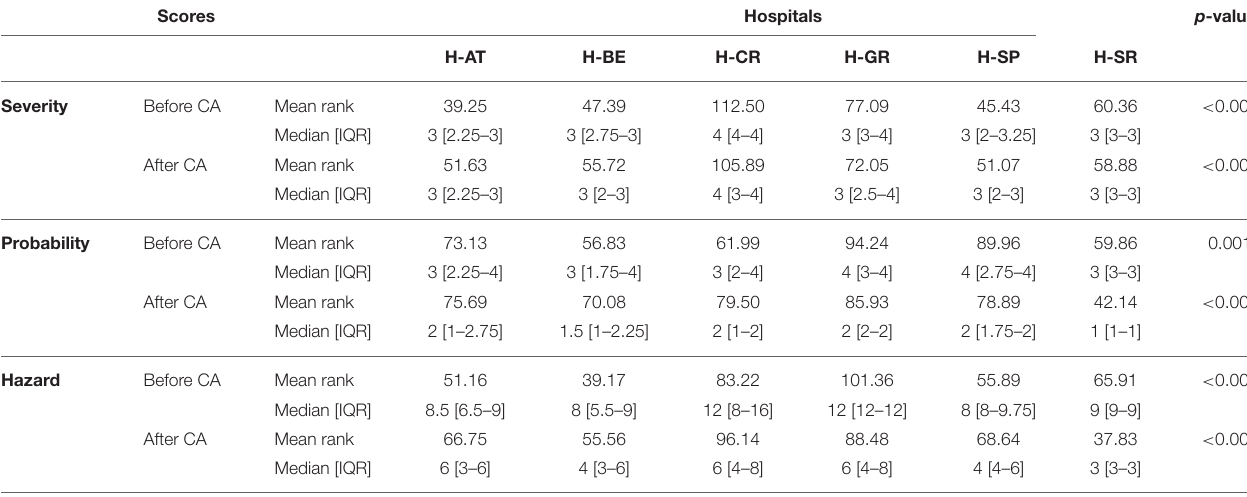
TABLE 4 | Comparison of the severity, probability, and hazard scores among countries. Scores Hospitals p -value a H-AT H-BE H-CR H-GR H-SP H-SR Severity Before CA Mean rank